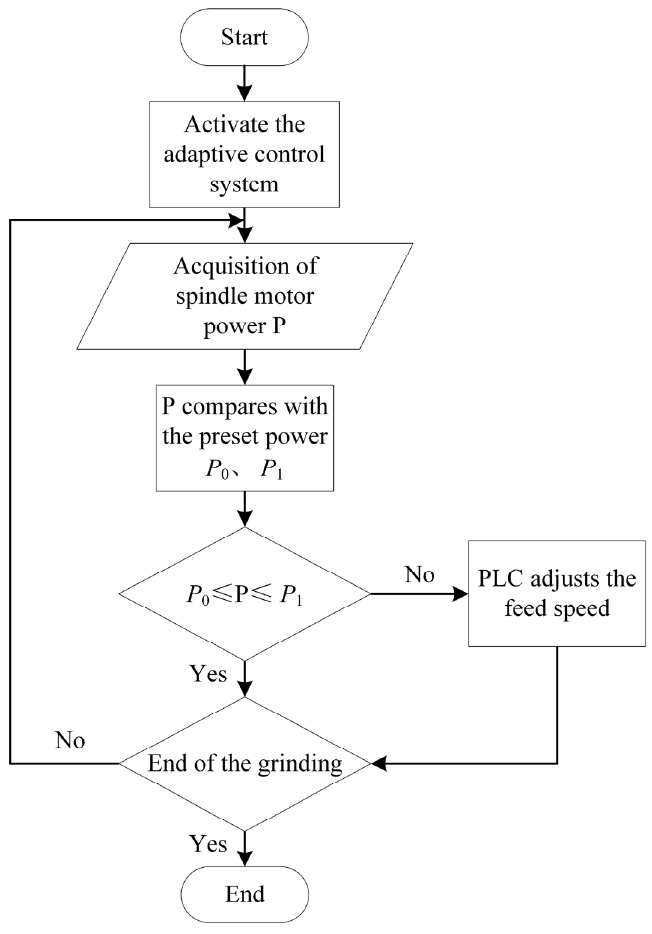
Figure 8. Flowchart of adaptive control of the grinding force.